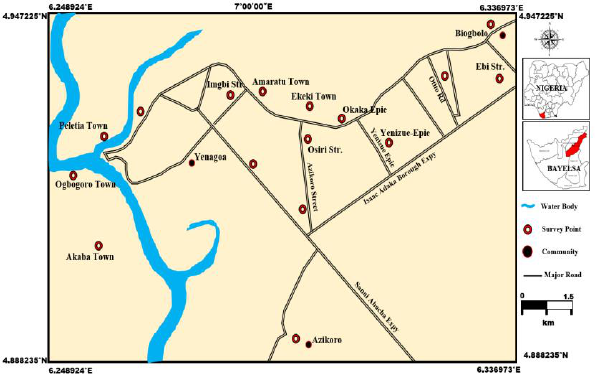
Figure 1: Map of Study Area showing VES